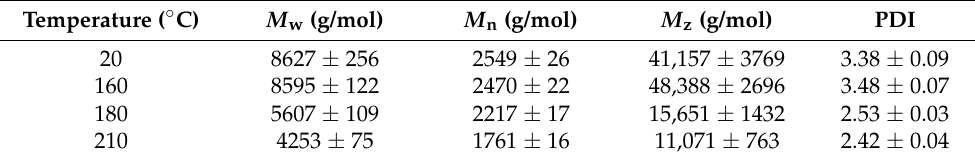
Table 6. Molecular weights and polydispersity index of lignin from padauk wood (mean ± SD).